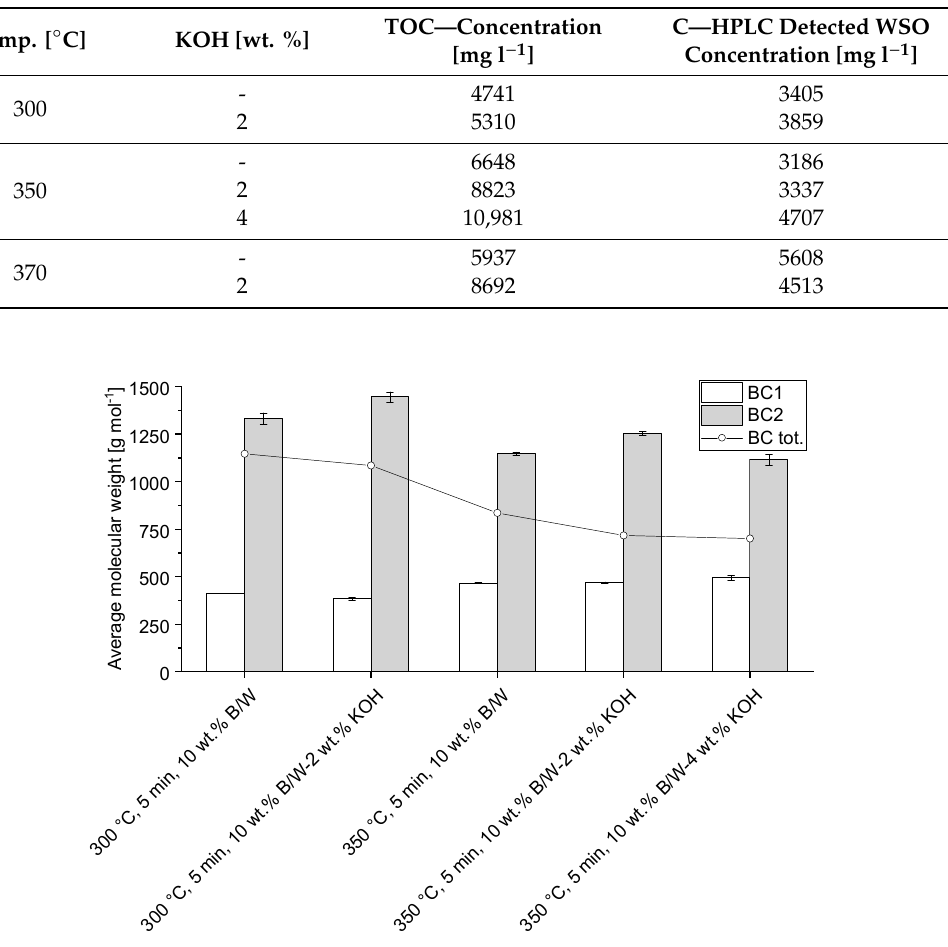
Figure 8. Effect of base catalyzed reaction, increasing KOH to LRS ratio from 2 wt. % to 4 wt. %: average molecular weight of BC1, BC2, and total biocrude. Error bars represent absolute standard deviation.